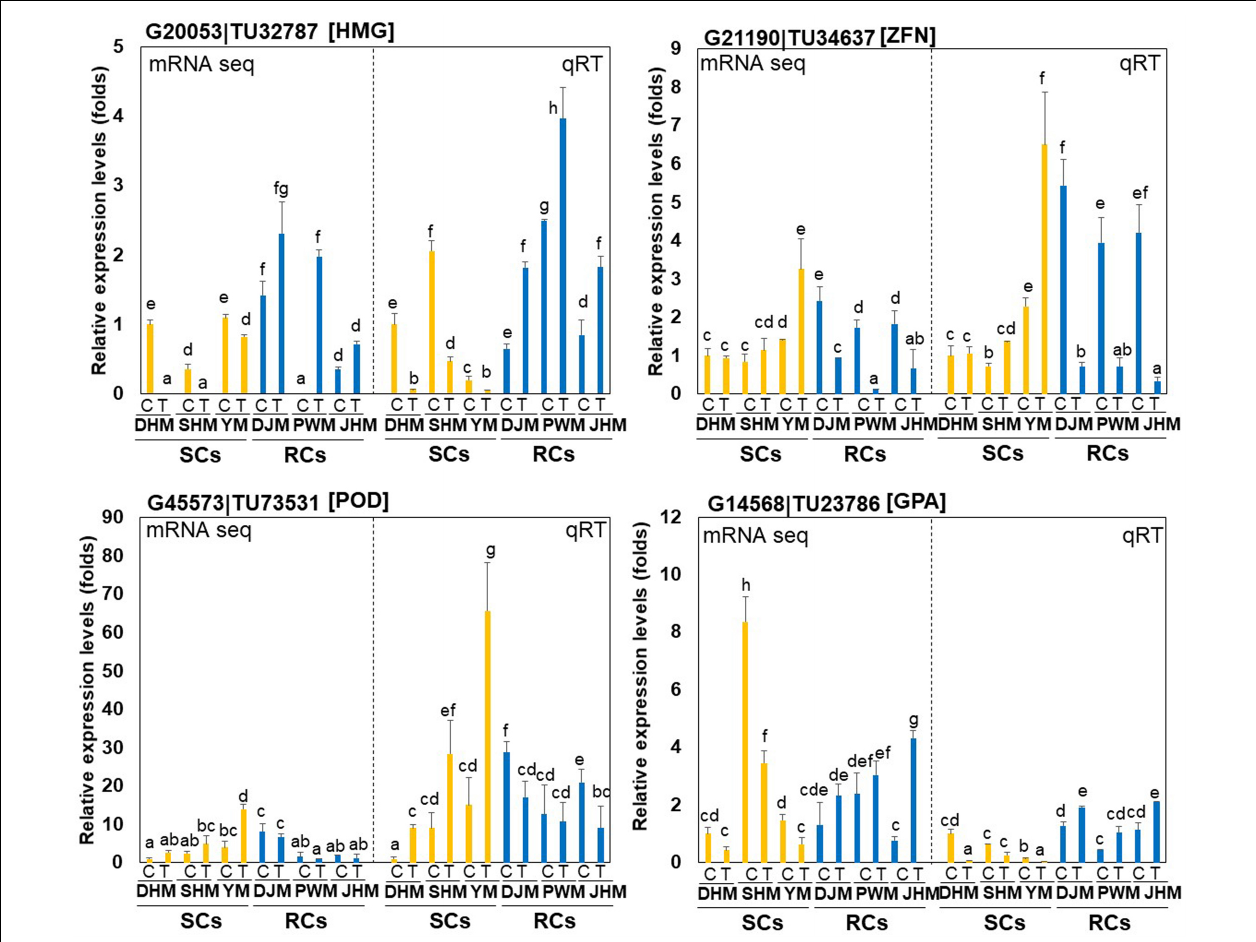
FIGURE 5 | Comparison of quantitative real-time PCR (qRT-PCR) results and RNA-seq data. The graphs show relative transcript levels of two RC-specific genes, hydroxymethylglutaryl-CoA synthase (HMG; G20053| TU32787) and zinc finger protein (ZFN; G21190| TU34637), and two SC-specific genes, cationic peroxidase (POD; G45573| TU73531) and glycerol-3-phosphate acyltransferase (GPA; G14568| TU23786), which were differentially expressed between SCs (yellow bars) and RCs (blue bars) infected with M. incognita , as determined by RNA-seq (left Y -axis) and qRT-PCR (right Y -axis). DHM, Dahomi; DJM, Danjami; PWM, Pungwonmi; SHM, Shinhwangmi; JHM, Juhwangmi; YM, Yulmi; RCs, resistant cultivars; SCs, sensitive cultivars; C, control; T, treatment. Bars denoted with the same letter are not significantly different ( P = 0.05) according to Dunnett’s